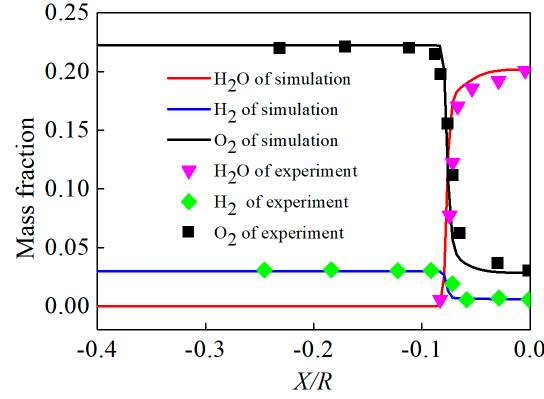
Figure 11. The composition distributions of simulation and experiment.